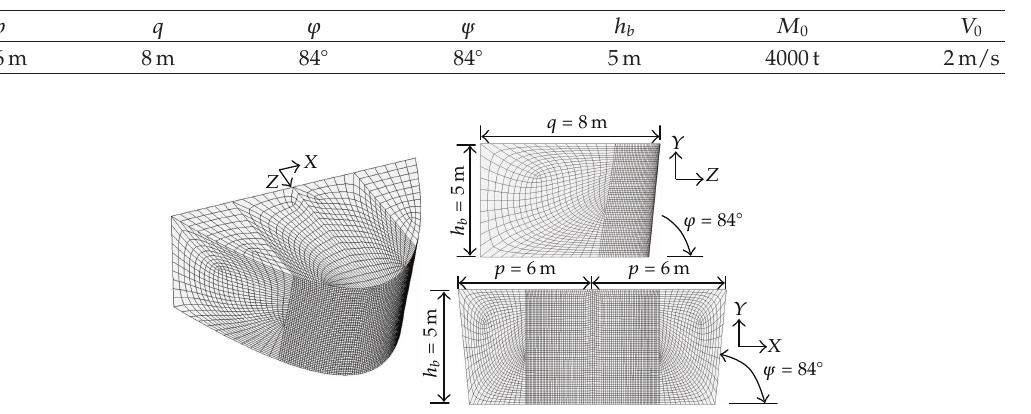
Table 1: Numerical data describing the striking vessel.